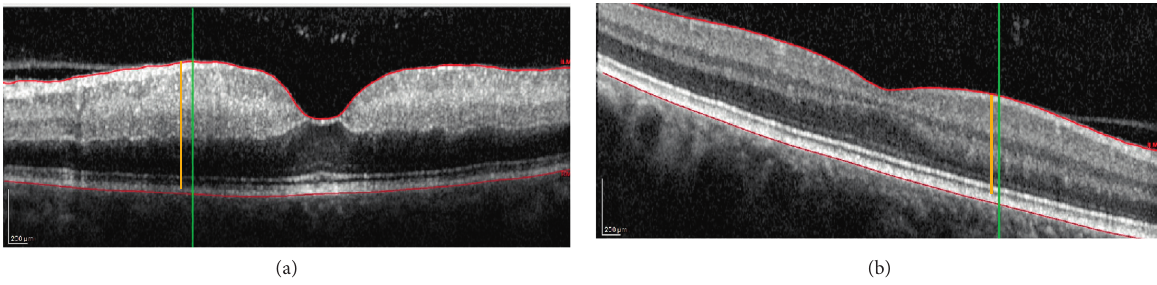
Figure 4: Automatic versus manual determination of retinal thickness representative optical coherence tomography (OCT) scan for the affected eye (a) and the unaffected eye (b). The scan in the unaffected eye is diagonal. Measurements are performed manually (orange line) and automatically (green line). The manual measurement equals 466 µ m (a) and 335 µ m (b), while the automatic is 474 µ m (a) and 377 µ m (b). The absolute retinal thickness increase (ARTI) is therefore different: 1.26 in the manual measurement and 1.39 in the automatic.